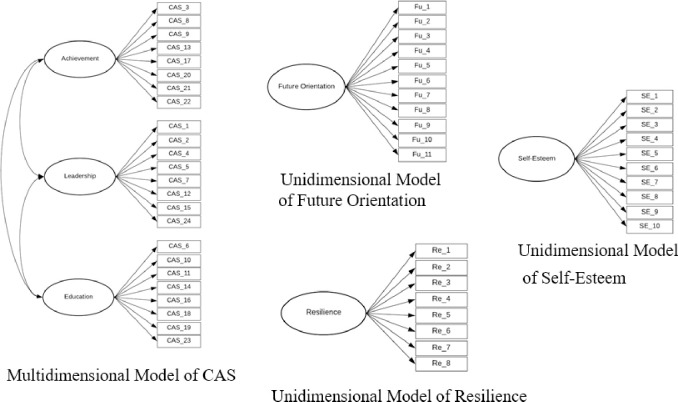
Measurement models tested.